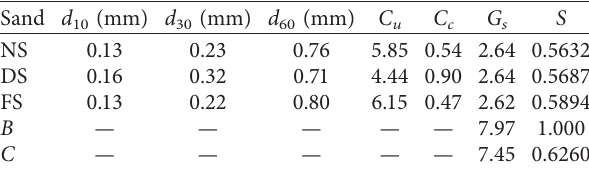
Figure 5: Samples of synthetic materials: (a) B ; (b) C . Table 1: Some physical properties of the materials tested.